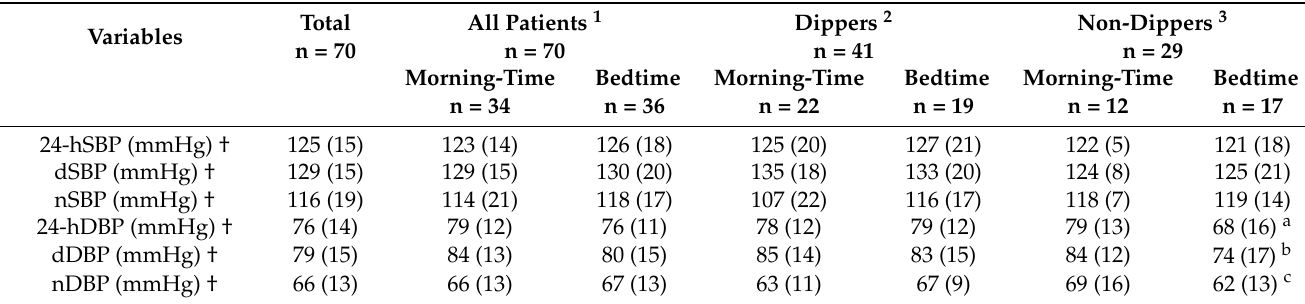
1 Comparisons between hypertensive patients with morning and bedtime use of RAAS blockers. 2 Comparisons between dipper patients with morning and bedtime use of RAAS blockers. 3 Comparisons between non-dipper patients with morning and bedtime use of RAAS blockers ( a p = 0.014, b p = 0.016, c p = 0.027). Comparisons in which the p -value was not provided have not reached statistical significance. RAAS–Renin-angiotensin-